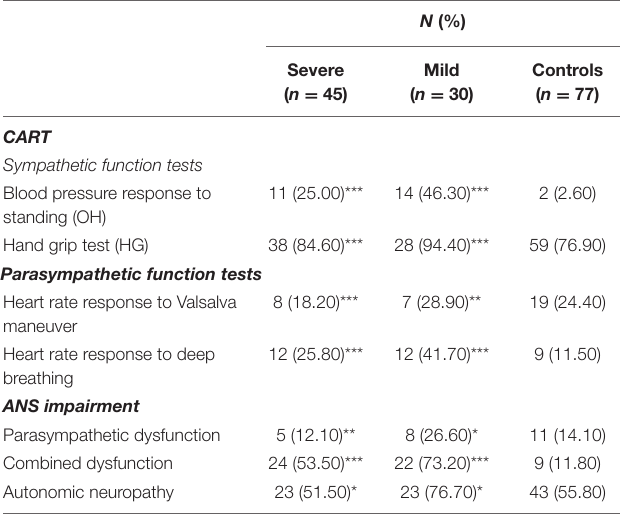
TABLE 2 | Abnormal results of cardioreflex tests in COVID-19 based on severity of disease.